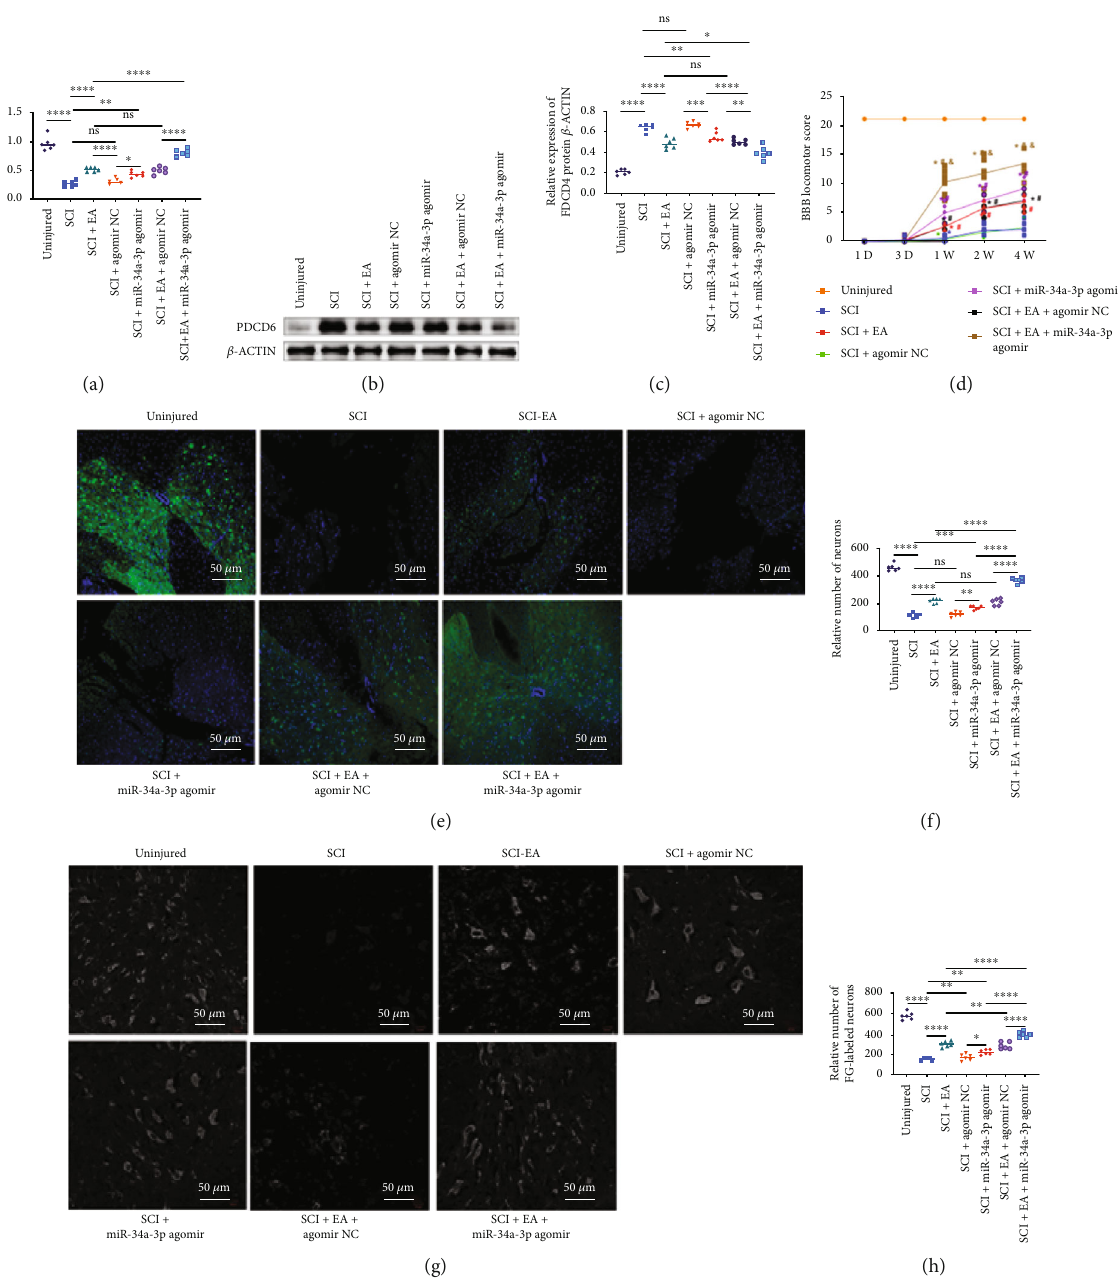
Figure 5: EA upregulates miR-34a-3p to exert post-SCI regenerative e ff ects comparable to EA stimulation through suppressing PDCD6. (a) qRT-PCR analysis of PDCD6 expression after treatment with SCI with and without EA stimulation and miR-34a-3p agomir treatment conditions. (b) Western blotting analysis of PDCD6 expression. (c) Quantitative analysis of PDCD6 levels. (d) Determination of the relative BBB locomotor score in di ff erent treatment groups. (e) Analysis of the continuity of neuro fi lament. (f) Quanti fi cation of the number of neurons after staining for continuity analysis. (g) Analysis of regenerative neuron by FG labeling. (h) Quanti fi cation of FG- labeled neurons. Scale bars = 50 μ m . Except for (d), one-way ANOVA followed by the Tukey ’ s multiple comparison test were utilized to identify di ff erences. ∗ p < 0 : 05 , ∗∗ p < 0 : 01 , ∗∗∗ p < 0 : 001 , ∗∗∗∗ p < 0 : 0001 , and ns: nonsigni fi cant among the compared groups. For (d), repeated measures two-way ANOVA followed by Tukey ’ s multiple comparison test were utilized and ∗ p < 0 : 05 versus the sham-operated (uninjured) group; # p < 0 : 05 versus the SCI group; & p < 0 : 05 versus the SCI+EA+agomir NC group. All the experiments were performed in triplicate from six animals ( n = 6